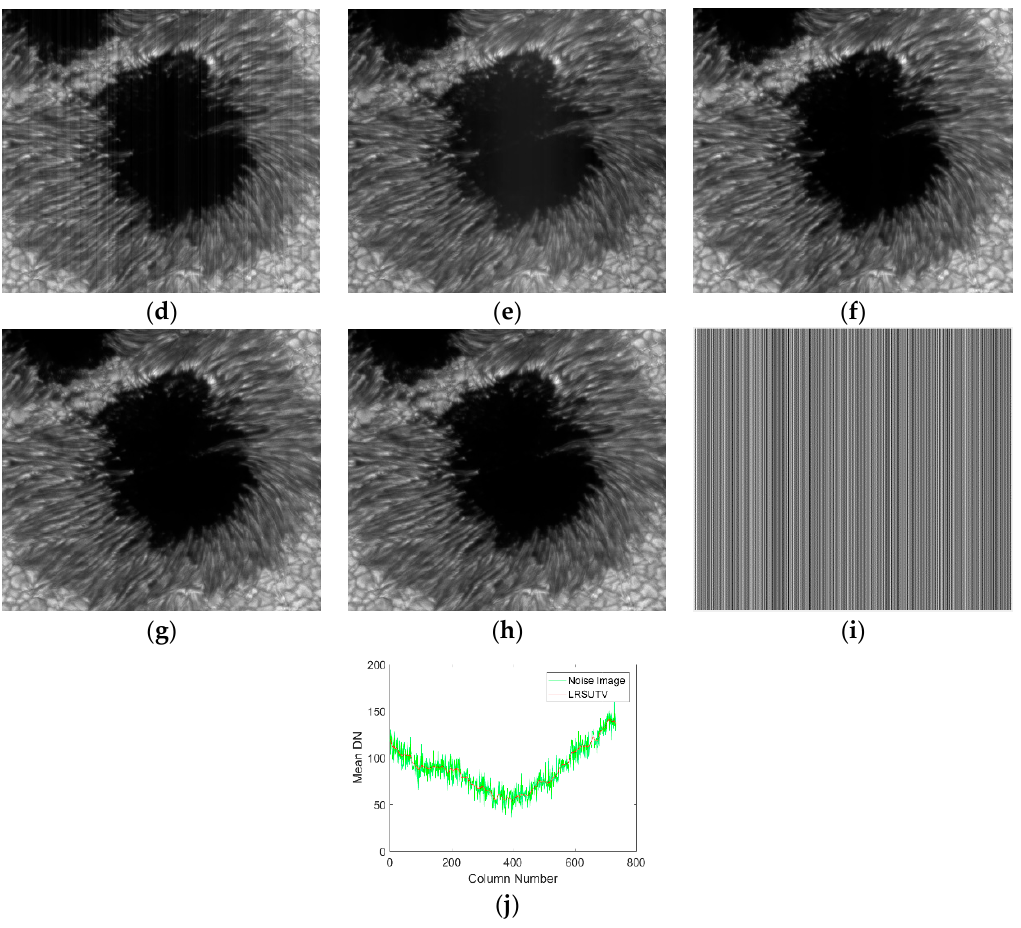
Figure 18. Denoising effect of various methods in the area of sunspot. ( a ) Noise Image; ( b ) WAFT; ( c ) UTV; ( d ) ASSTV; ( e ) VSNR; ( f ) SILR; ( g ) ℓ 0 sparse; ( h ) LRSUTV; ( i ) CFPN noise estimated by LRSUTV method; ( j ) mean cross track of images ( a ) and ( h ).